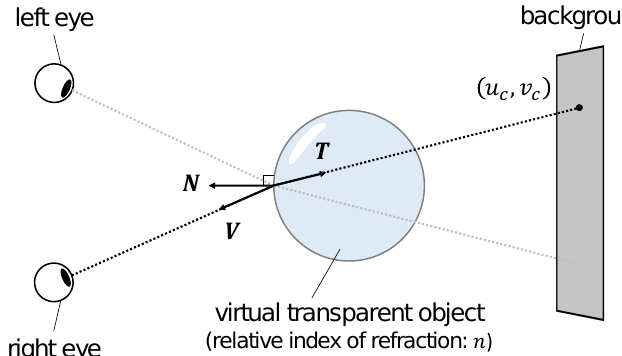
Figure 8. Model for calculating